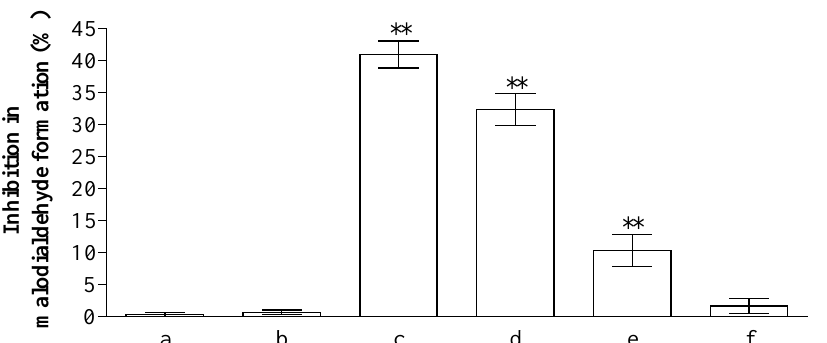
a b Figure 1. Inhibition (%) of erythrocyte membranes lipid peroxidation by Jatropha curcas L. methanol extract. Hemolysates plus 100 µM of tert-butylhydroperoxide (t-BOOH) were incubated for 30 min in the absence (a) or in the presence of 1.0, 0.5, 0.25, and 0.1 µM GAE (c–f). To check the possible influence of the solvent present in the extract, we incubated the hemolysates in the presence of the same amounts of methanol present in the samples (b). The values are expressed as mean ± SD ( n = 3). The ** shows significant statistical differences ( p < 0.05) with respect to erythrocyte membranes treated in the presence of only t-BOOH.